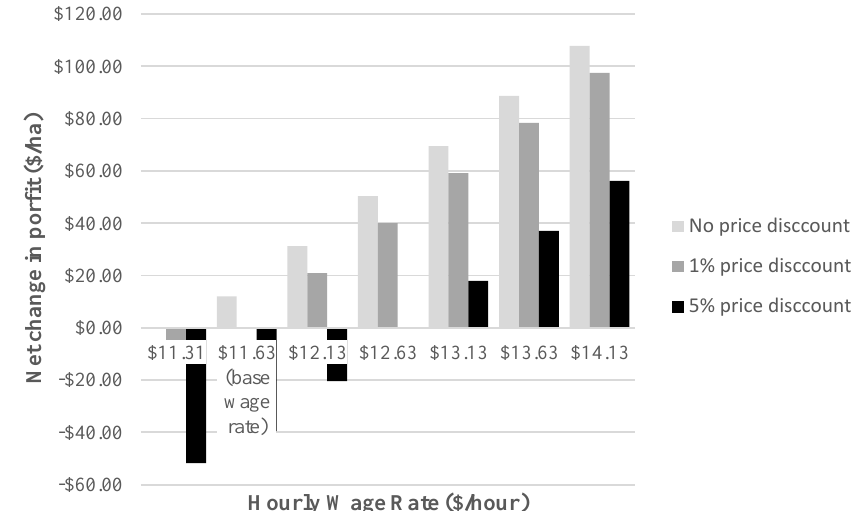
Figure 2. Net changes in profit associated with the adoption of BDMs given different hourly wage rates and pumpkin price discounts (no pumpkin price discount; 1% and 5% pumpkin price discount).